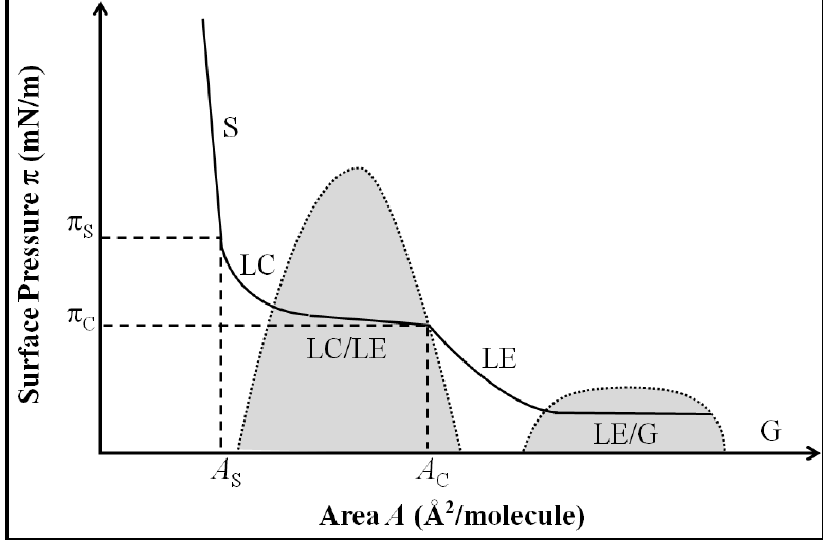
Figure 1. Representation of phospholipid surface pressure ( π ) vs. area per molecule (A) isotherm. Grey areas represent the coexistence regions (LC-LE and LE-G). S: solid-like structure region; LC: liquid-condensed region; LE: liquid-expanded region; G: gaseous and A are the transition pressure and area, respectively, between liquid-like and region. π S S solid-like structures. π and A are the critical pressure and area, respectively, between LE C C and LC/LE coexistence regions (Adapted from Möhwald